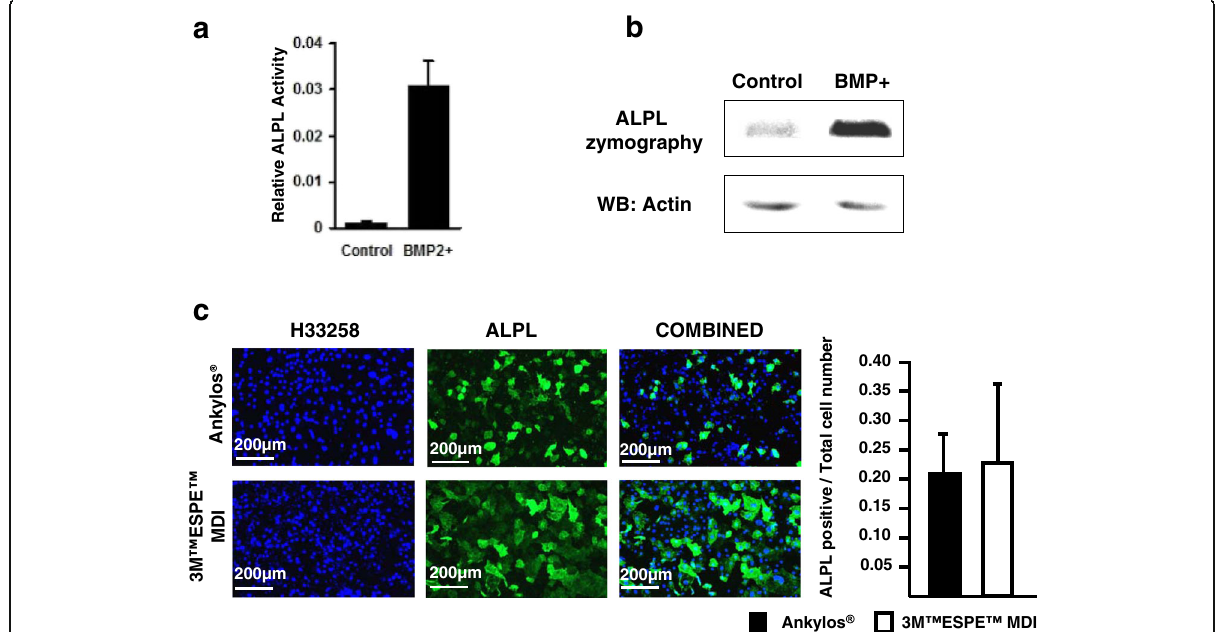
Fig. 4 a C2C12 cells (control) and pBMP-2-transfected C2C12 cells were seeded on a 24-well plate (50,000 cell/well) and cultured in DMEM medium for 48 h. ALPL assay showing upregulated ALPL activity in the BMP-2-transfected C2C12 cells. b Cell extracts of C2C12 cells and pBMP-2- transfected cells were run on a 10% SDS-PAGE under non-denaturing conditions. The gel was then stained with NBT/BCIP solution (upper panel). Western bloting of actin showing the equal protein loading on the gel ( lower panel ). c Increased proliferation of C2C12 cells transfected with BMP-2 as well as ALPL activity when seeded on 3M ™ ESPE ™ MDI disks. However, when the number of ALPL-positive cells is normalized to the total cell number, no differences are